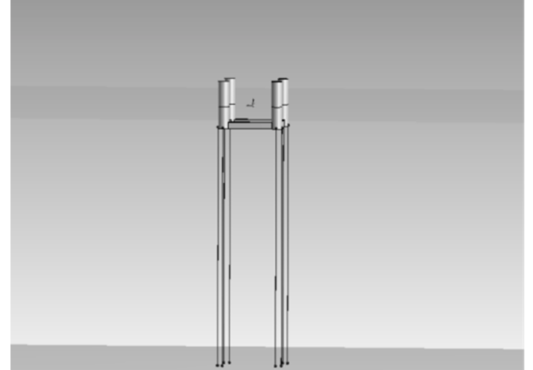
Figure 3. Diagram of the ISSC TLP.